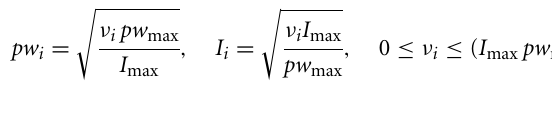
shoulder flexion/extension angle ϑ u for an averaged upper arm weight of 2.15kg and a forearm/hand weight of 1.91kg with the elbow flexed at 90 ◦ . The resulting additional torque when the electromagnetic brake is switched on is shown as blue dash-dotted line.